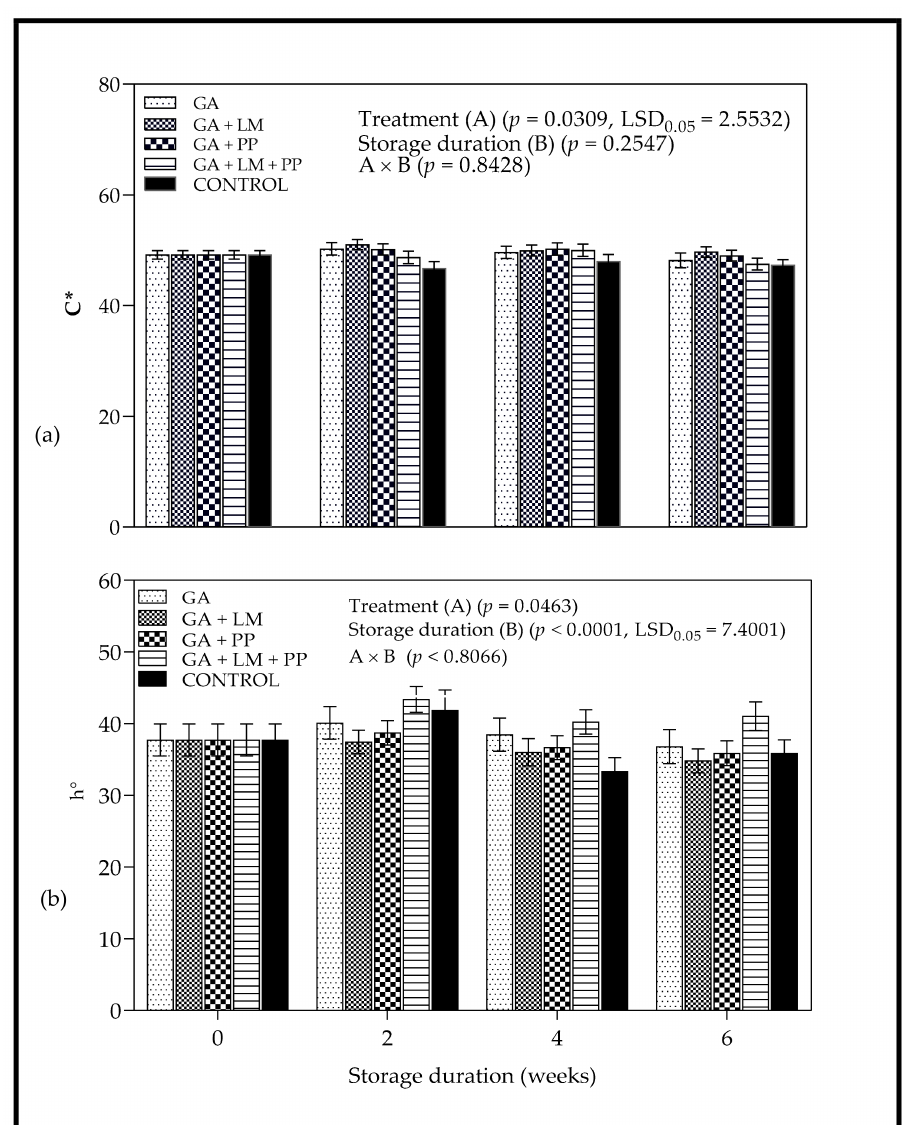
Figure 7. Color attributes, ( a ) Chroma (C*) and ( b ) hue angle (h ◦ ) of ‘Wonderful’ pomegranate whole fruit coated with gum arabic (GA) coatings enriched with lemongrass oil (LM) (0.1% v/v ) and/or pomegranate peel extract (PP) (0.1% w/v ) and stored at 5 ± 1 ◦ C (95 ± 2 % RH) for 6 weeks followed by 5 d at shelf-life conditions (20 ± 1 ◦ C and 60%RH). Vertical bars represent the standard error (SE) of mean value calculated from 10 measurements per treatment (1 fruit = 1 measurement). LSD 0.05 represents least significant difference ( p <